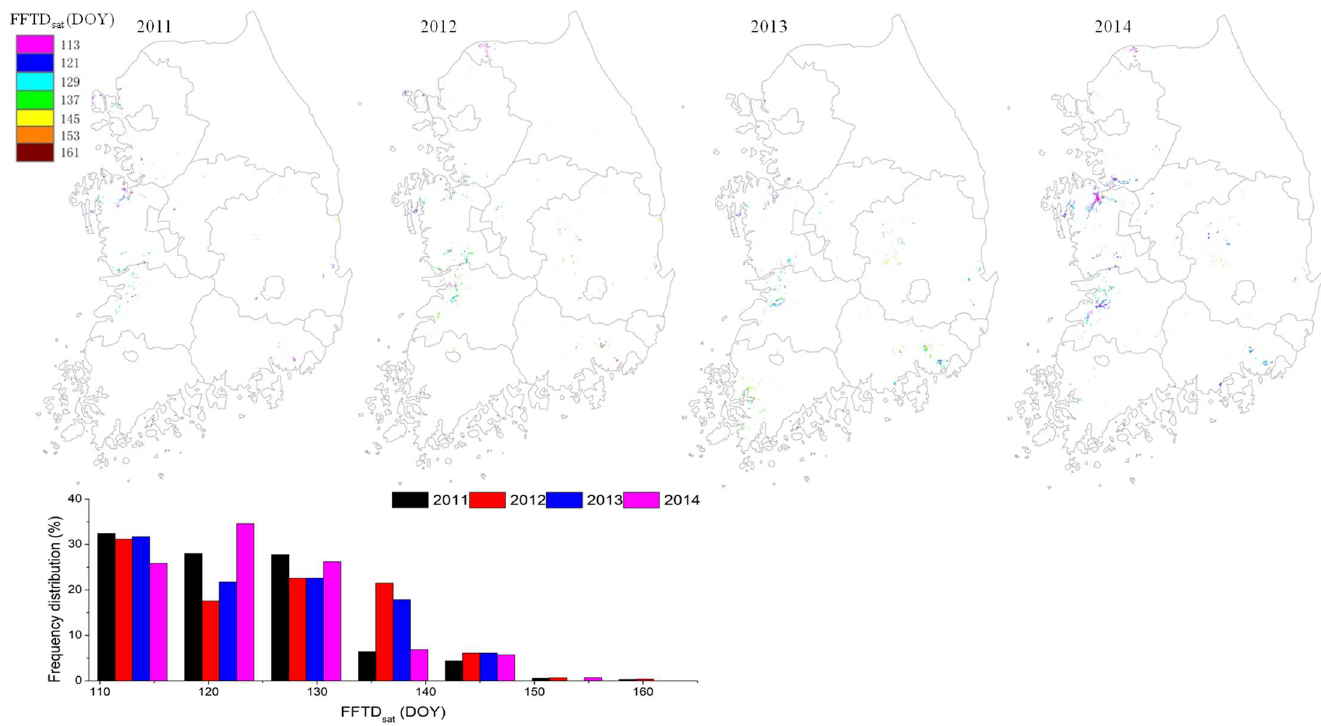
Figure 6. The spatial distribution map of the first date of field flooding and transplanting detected by satellite observations ( FFTD sat ) and FFTD sat frequency distribution map in paddy rice fields in South Korea from 2011 to 2014. DOY : the day of year.